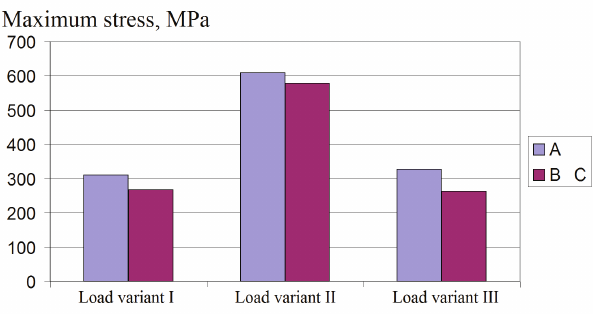
Figure 11: Comparison of maximum stresses in arch support A and B and C for different load patterns.